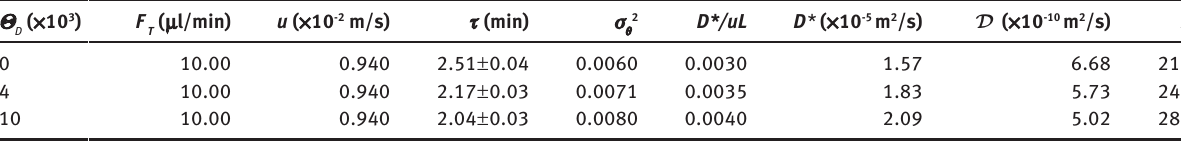
Table 6 Comparison of dispersion for varying dimensionless dispersant concentrations. Θ ( × 10 3 D